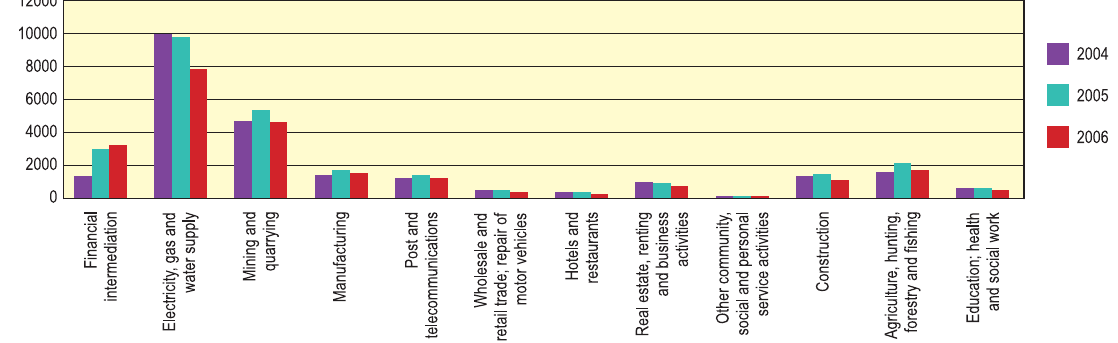
Fig. 2. Ratio of GDP of specifi c economic activity to number of enterprises operating in that economic activity ( indicates GDP per company in considered economic